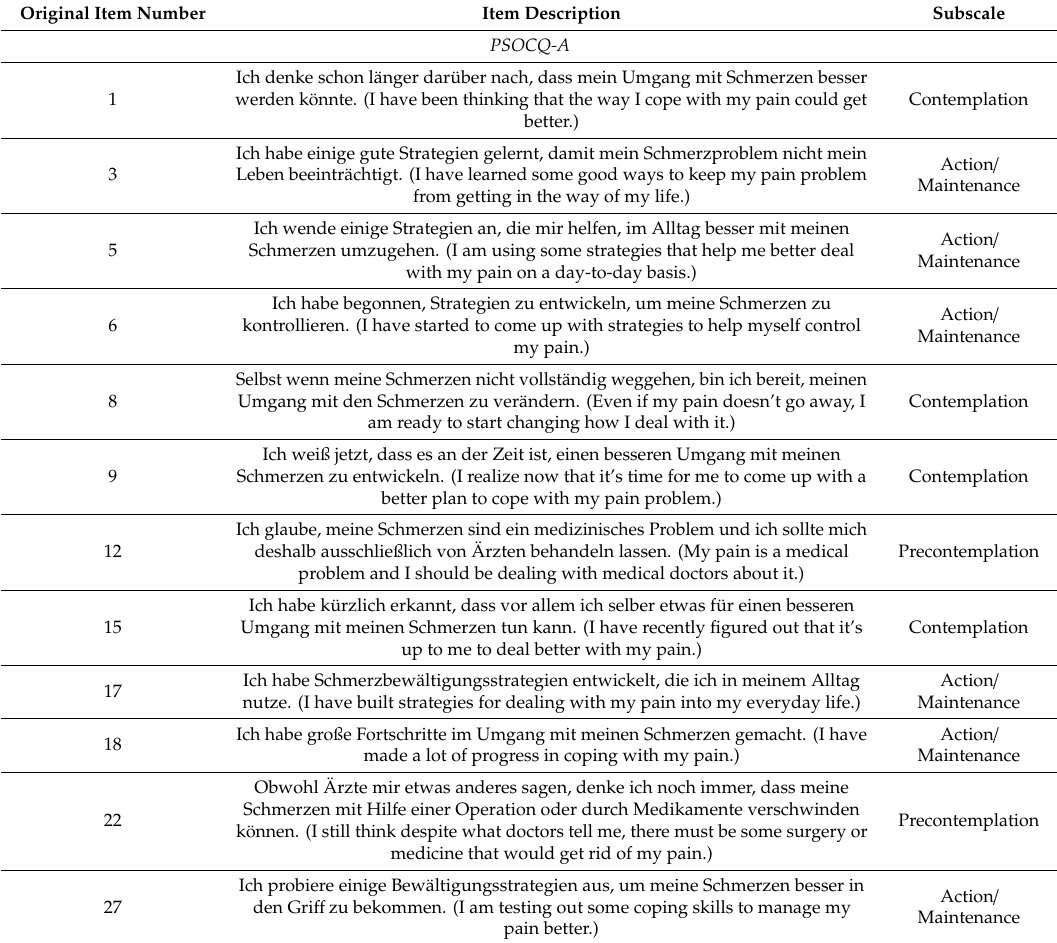
Table A1. Short versions of the PSOCQ-A and the